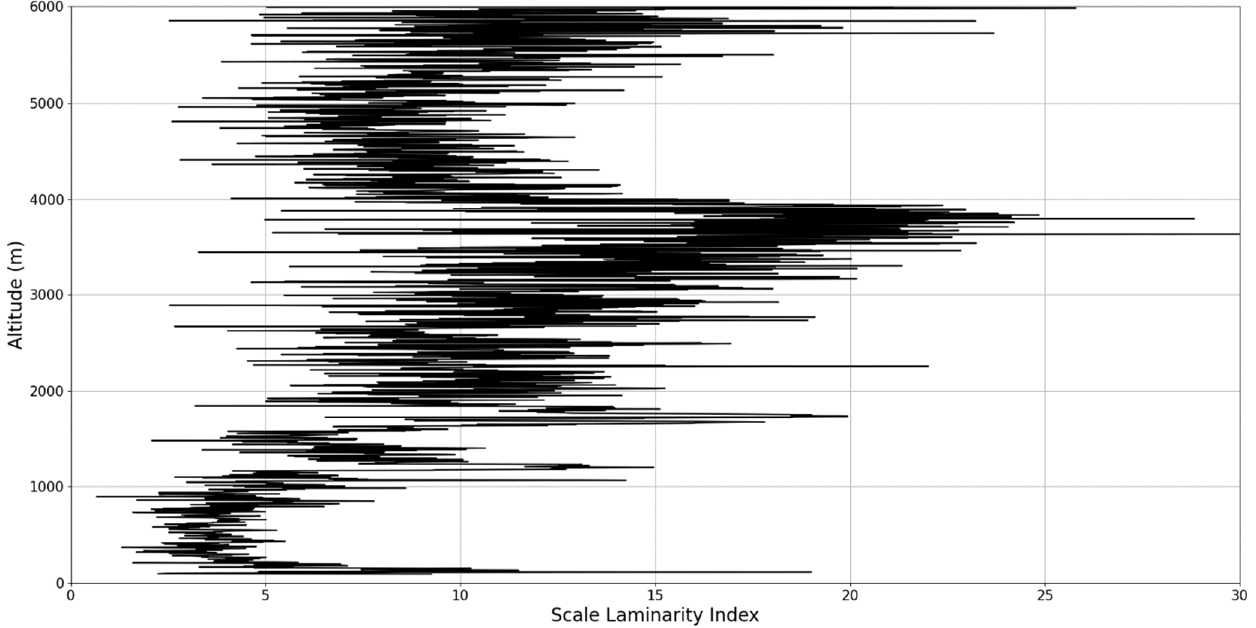
Figure 29. Scale laminarity index profile plot corresponding to point B.